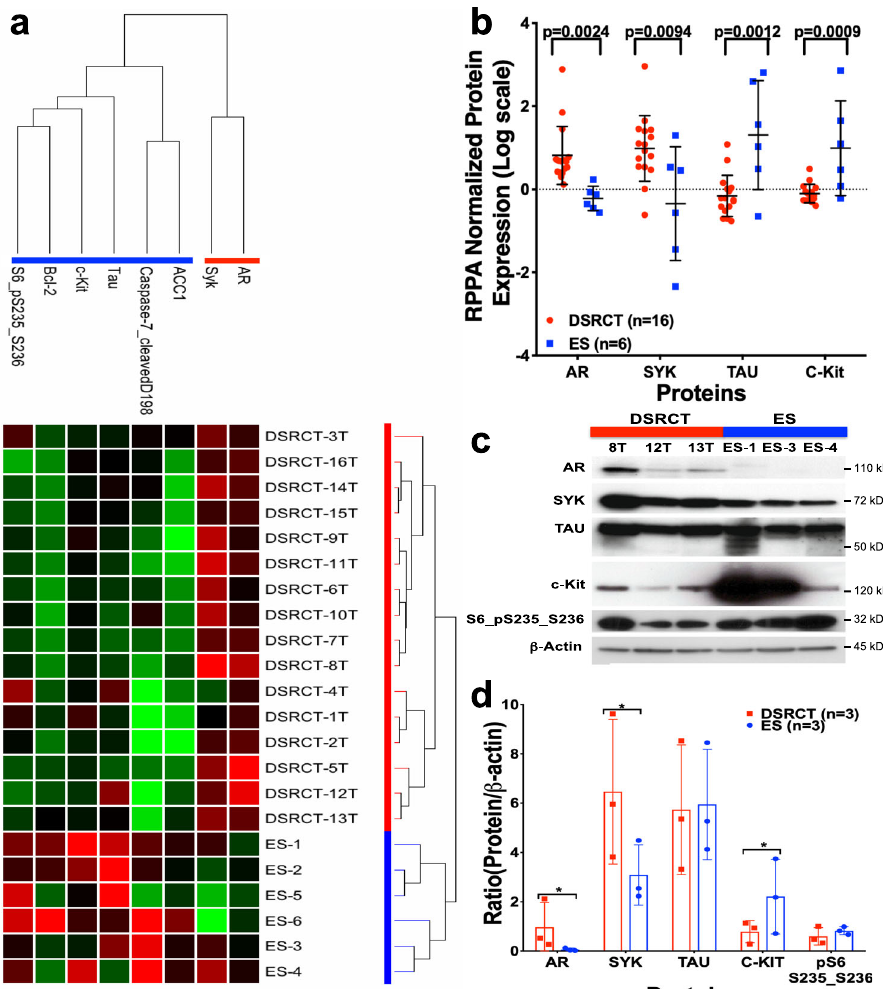
Fig. 1 Proteomic comparison of DSRCT and ES. a The protein lysates from DSRCT (red; n = 16) and ES (blue; n = 6) were subjected to RPPA analysis for 151 proteins and phosphoproteins (red, increased signal; green, decreased signal). Unsupervised double-hierarchical clustering using the Pearson correlation distance metric between proteins (rows) and Centroid linkage (a clustering method) separated the 22 samples into two groups by tumor type (columns). Of the 22 proteins, 8 had expression that differed signi fi cantly between ES and DSRCT ( p ≤ 0.05; fold-change ≥ 2). b The mean expression intensity values of the 8 proteins associated with DSRCT or ES and their statistical signi fi cance after normalization for global protein expression by median centering across 151 antibodies in the RPPA panel. c Western blotting was used to validate the proteins identi fi ed by RPPA as being differentially expressed between DSRCT and ES. d Normalized protein expression is relative to β -actin. Data points in b and d represent mean ± SD. n is the number of samples analyzed for each sarcoma